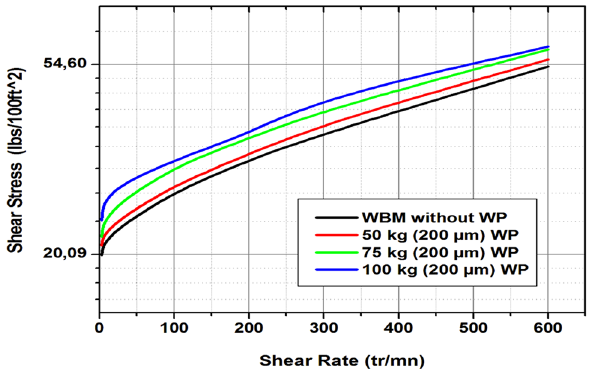
Fig. 3 PAC_ul and CMC substituted by wood powder (WP at size = 200 µm) at different contents